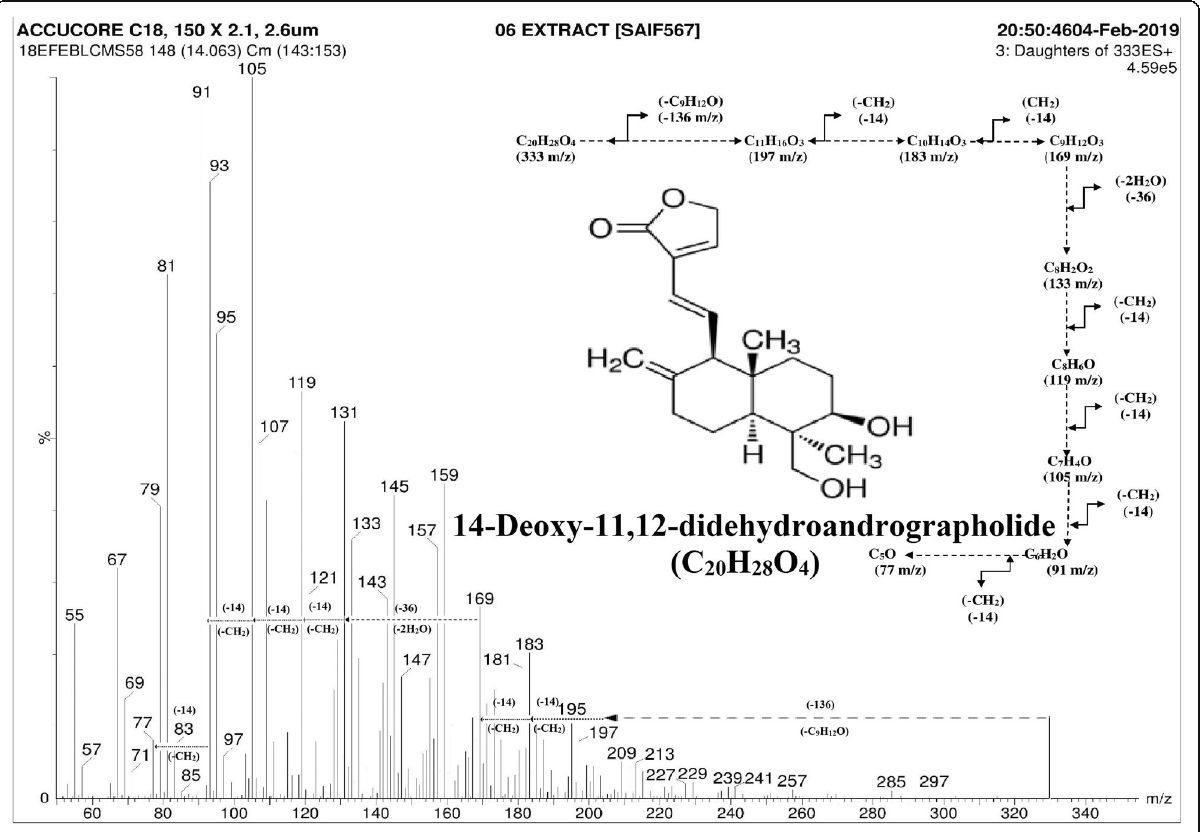
Fig. 7 Fragmentation pathway of 14-deoxy-11,